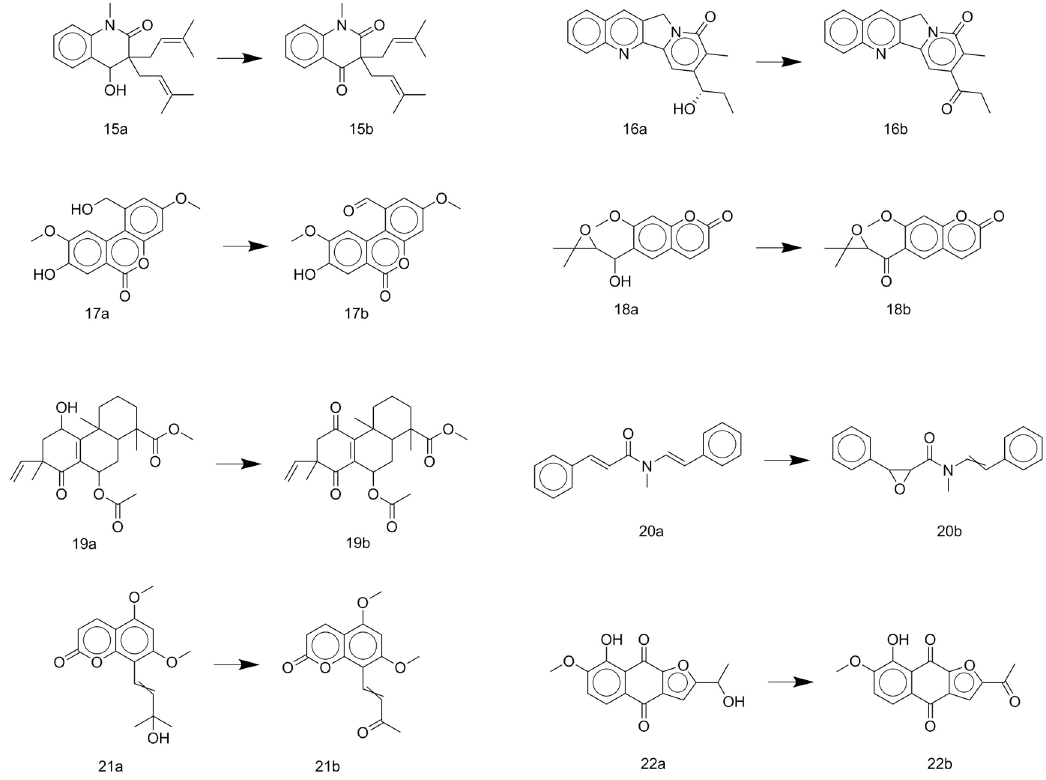
Figure 4. Some typical cases of reactive natural products and their probable artifacts caused by oxidation in the result data set.